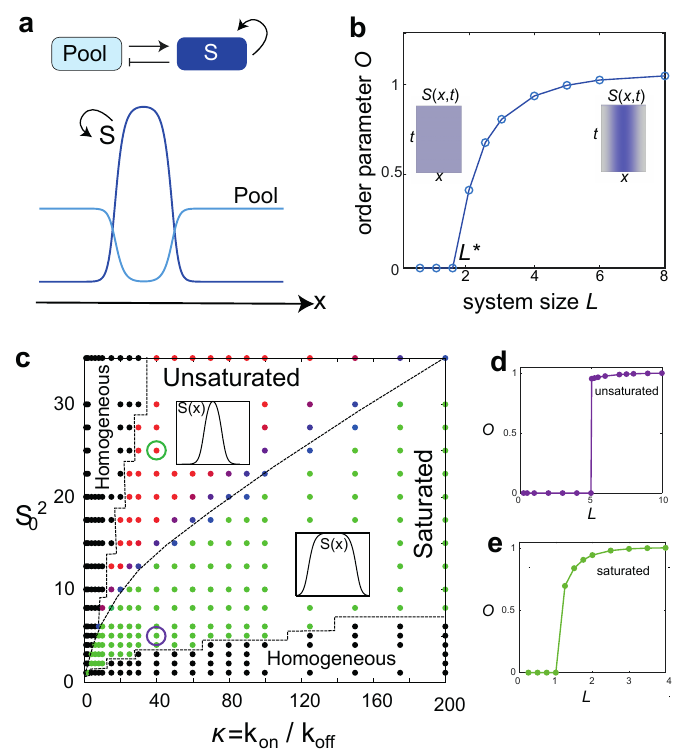
Figure 1. Size-regulated symmetry breaking in activator–substrate model. ( a ) Pattern formation in a model of positive feedback coupled to a finite constituent pool. ( b ) Patterns form above a critical system size ( L ∗ ), corresponding to the largest mode where the homogeneous state becomes unstable and the system breaks symmetry. The order parameter O for symmetry breaking is defined as O ( L ) = (cid:20) (cid:21) (cid:82) L (cid:82) L | dS / dx | / | dS / dx | , where O is zero for a homogeneous state and O = 1 for a symmetry max 0 0 L broken patterned state. All parameters other than system size was kept constant in this analysis and (cid:82) P ( x , t ) + S ( x , t ) dx is the total initial perturbations were so chosen that N / L is constant, where N = = 10 and N / L = 1.5. ( c ) Phase diagram pool size. Parameters: D P = 1, D S = 0.05, k on / k off = 20, S 2 0 in the plane of autocatalytic activity κ and the Hill saturation parameter S 2 , showing three different 0 phases: homogeneous state (black), symmetry broken saturated state (green), and symmetry-broken unsaturated state (red). Colormap (green to red) denotes the average value of the reaction rate (cid:82) F av = F ( x ) dx , computed in the high density region, with F av = 0 in the saturated state and F av (cid:54) = 0 in the unsaturated state. F av = 0.01 (blue points) defines the crossover value from the saturated state to the unsaturated state. Parameter values are the same as ( b ) except for D S = 0.01 and L = 3. Inset: Profiles of S ( x ) . ( d – e ) Order parameter O for the unsaturated ( d ) and the saturated ( e ) regimes, showing that the symmetry of the homogeneous state is broken beyond a critical system size. We used periodic boundary conditions for all numerical simulations, unless otherwise specified. For initial conditions, we assumed a homogeneous P ( x ) and a sinusoidal S ( x ) profile of large